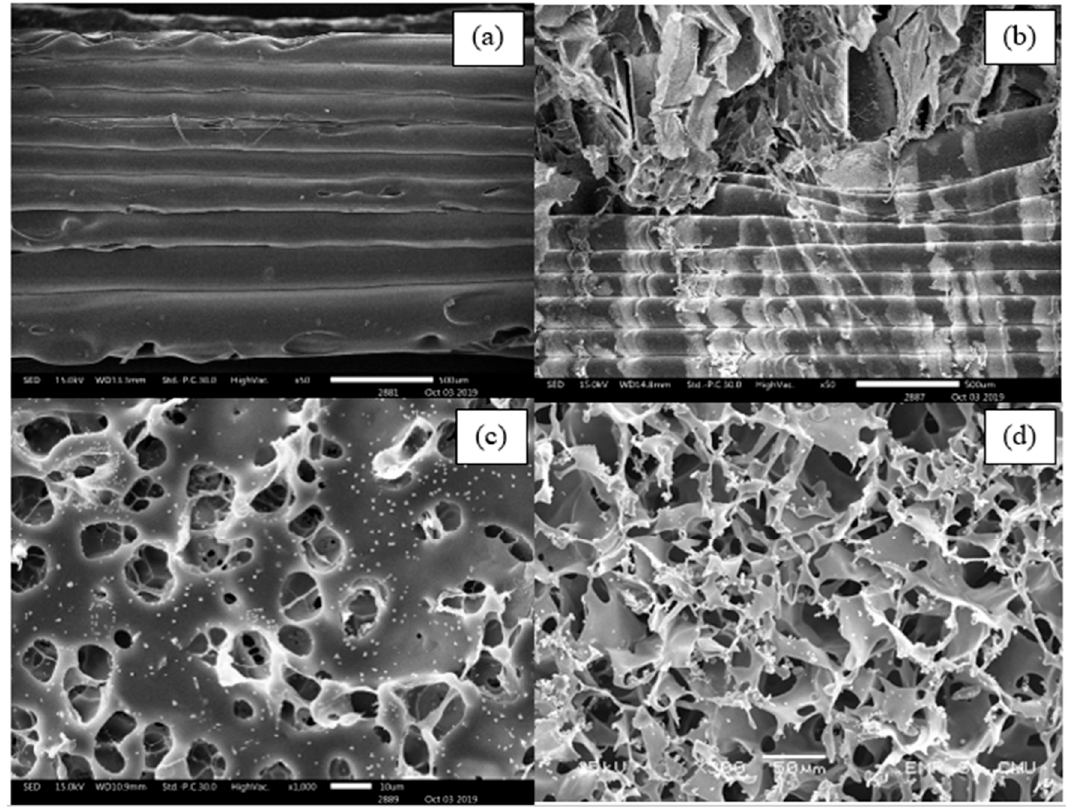
Figure 12. SEM images of the 3D-printed specimen for biological tests: ( a ) specimen without a SF coating, ( b ) specimen with a SF coating, ( c ) surface of the SF in the specimen cavity, and ( d ) bottom side of SF in the specimen cavity .